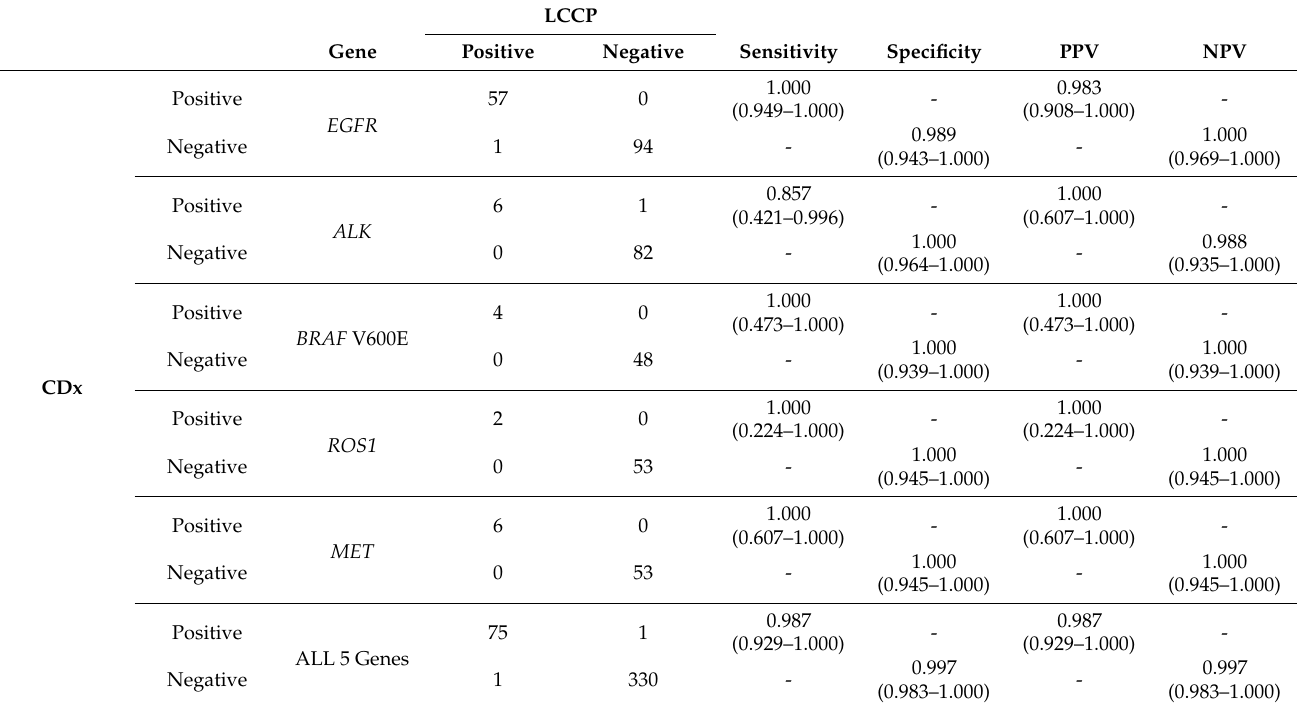
Table 2. Concordance of mutation call by CDx-tissue and LCCP-cytology. CDx: Companion di- agnostic test. LCCP: Lung cancer compact panel. PPV: Positive predictive value. NPV: Negative predictive